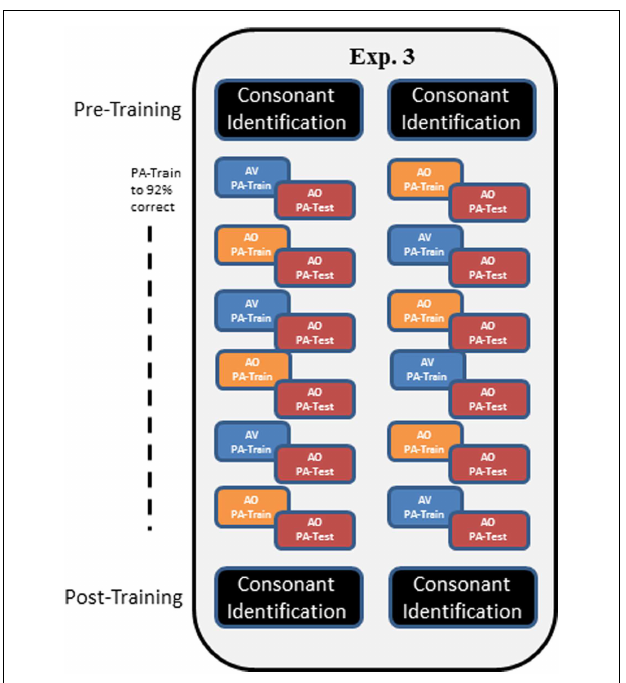
FIGURE 5 | Overall design of Experiment 3. In Experiment 3, participants carried out pre-training consonant identification, followed by alternating AV and AO training, counter-balanced across participants as shown by the two columns of train versus test in the figure.Training blocks on each list were repeated until the participant achieved 92% correct.Then AO testing was administered. Post-training, participants were tested again on AO forced-choice consonant